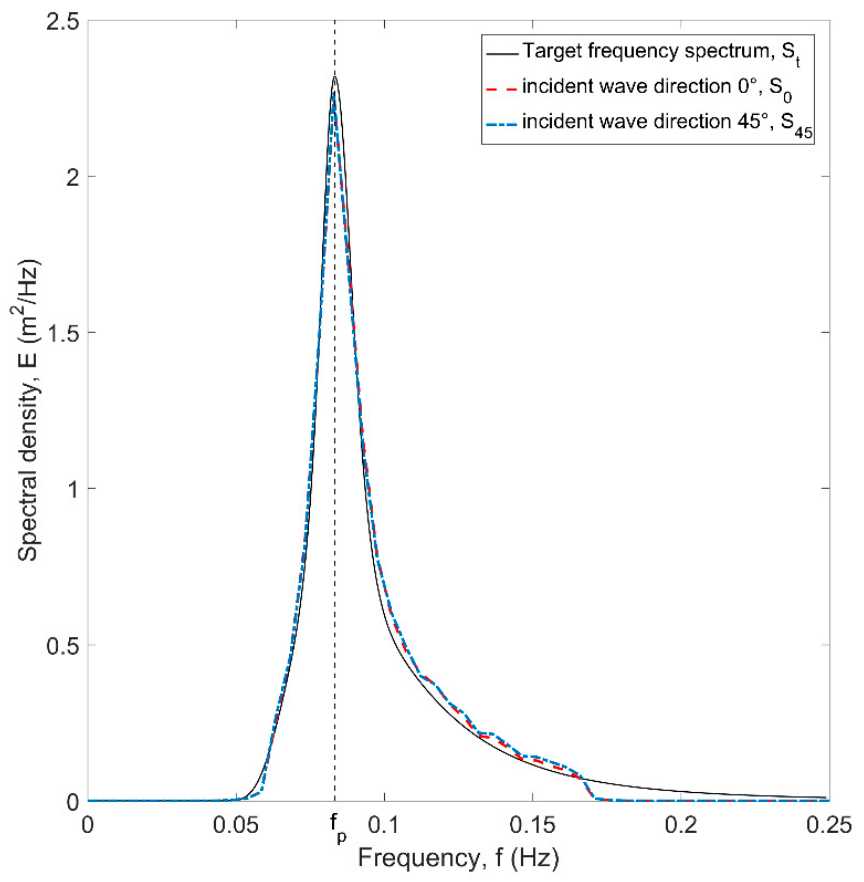
Figure 8. Comparison between the frequency spectra, S 0 and S 45 , resulting from MILDwave simulations for different incident wave angles ( θ = 0 ◦ and θ = 45 ◦ , respectively), and the target frequency spectrum, S t , for irregular waves with H s = 1 m, T p = 12 s, and γ = 3.3.